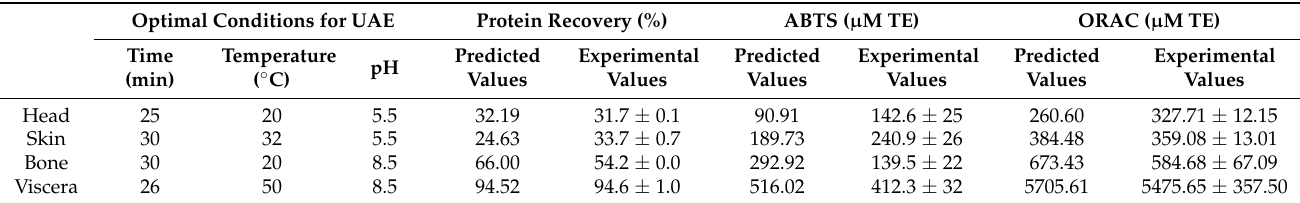
Table 9. Optimal conditions, predicted values, and experimental responses of protein recovery and antioxidant activities (ABTS and ORAC) for different fish side streams.